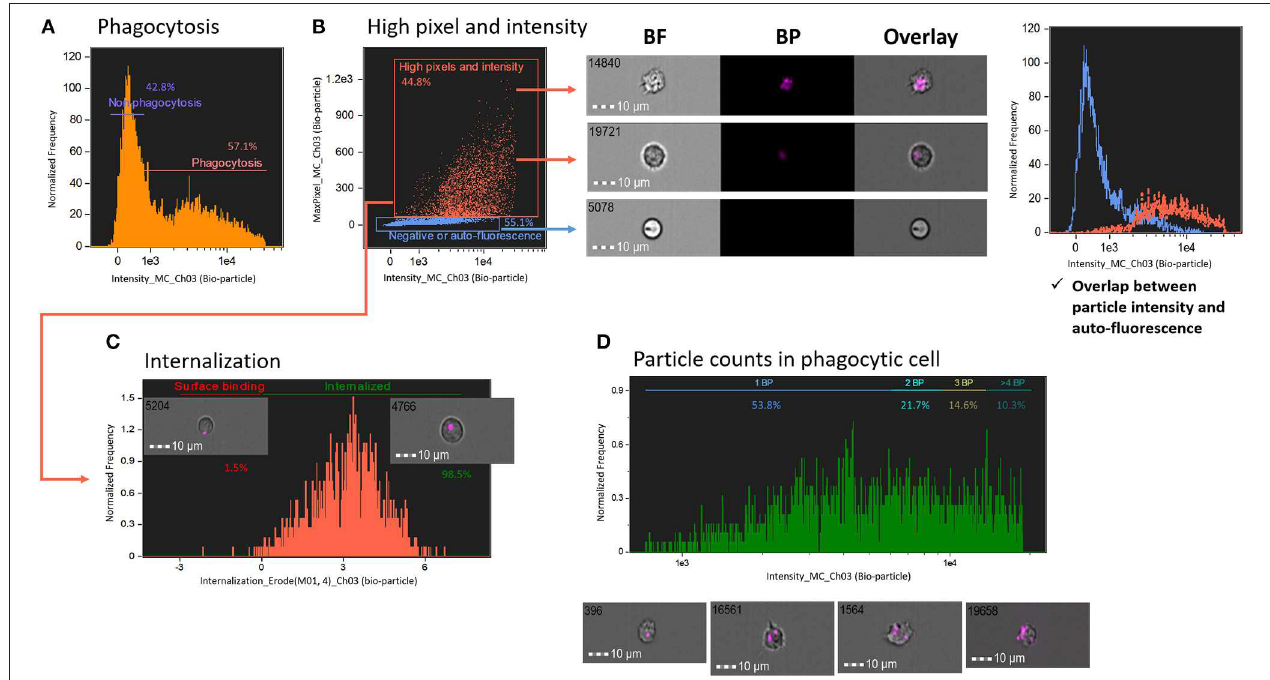
FIGURE 4 | Measurement of phagocytosis using degradable fluorescent particles (pHrodo TM ). (A) Live cells are plotted in a histogram of fluorescent bio-particle intensity. (B) To exclude auto-fluorescence and find the best image, images with more pixels and high intensity were gated. The histogram (right panel) points to the detection error caused by overlapping curves of particle intensity (orange) and auto-fluorescence (blue) in conventional flow cytometry. (C) Internalized cells were gated using internalization score. (D) Cells with internalized particles were plotted in a histogram of bio-particle intensity, which shows the number of particles. All cell images were captured with 40 × objective. Scale bar = 10 µ m. BF, brightfield; BP, bio-particle.